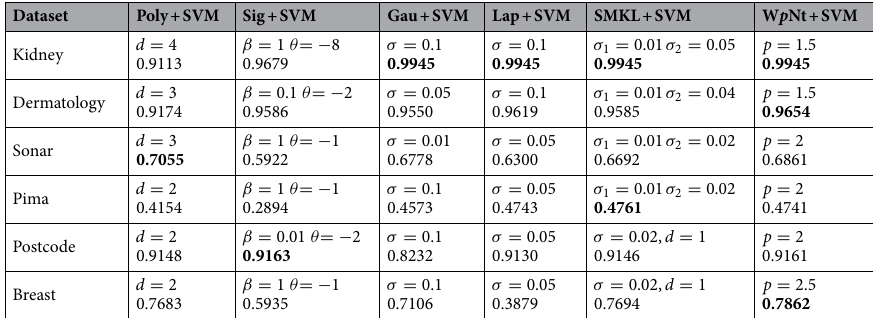
Table 5. The fivefold cross-validation classification Kappa coefficient based on the SVM algorithm with different kernel functions. Significant values are in bold.